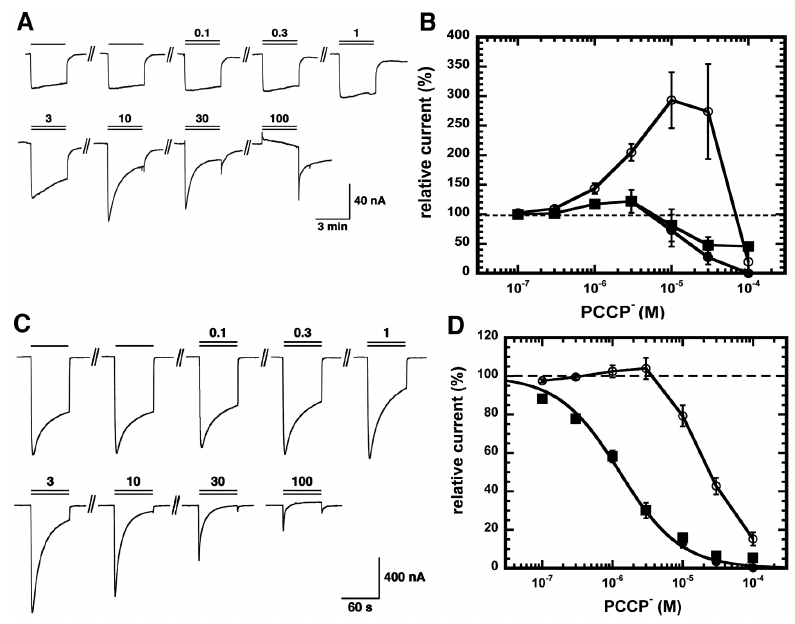
Figure 3. Effect of PCCP 2 on recombinant a 1 b 2 c 2 GABA A receptors. A, GABA A receptors were expressed in Xenopus oocytes. The electrical currents recorded by two-electrode voltage clamp were activated with a concentration of GABA eliciting 1% of the maximal current amplitude (EC 1 ) and inhibited with increasing concentrations of PCCP 2 . The lower bar indicates the time of GABA application, the upper bar the time of PCCP 2 application. The numbers indicate the concentration of PCCP 2 in m M. At concentrations . 1 m M, induces an open-channel block, characterized by an apparent desensitization of the current and an off-current. B, Averaged concentration inhibition curve by PCCP 2 . Individual curves were fitted and standardized to the current elicited by GABA. Data are shown as mean 6 SEM (n=4). Open circle: peak current amplitudes at the beginning of the drug application. Filled squares: current amplitudes at the end of the drug application. Filled circles: current amplitudes at the end of the drug application corrected for the direct effect of PCCP 2 on membranes. C) and D) same experiment carried out at a concentration of GABA eliciting 10% of the maximal current amplitude (EC 10 ).